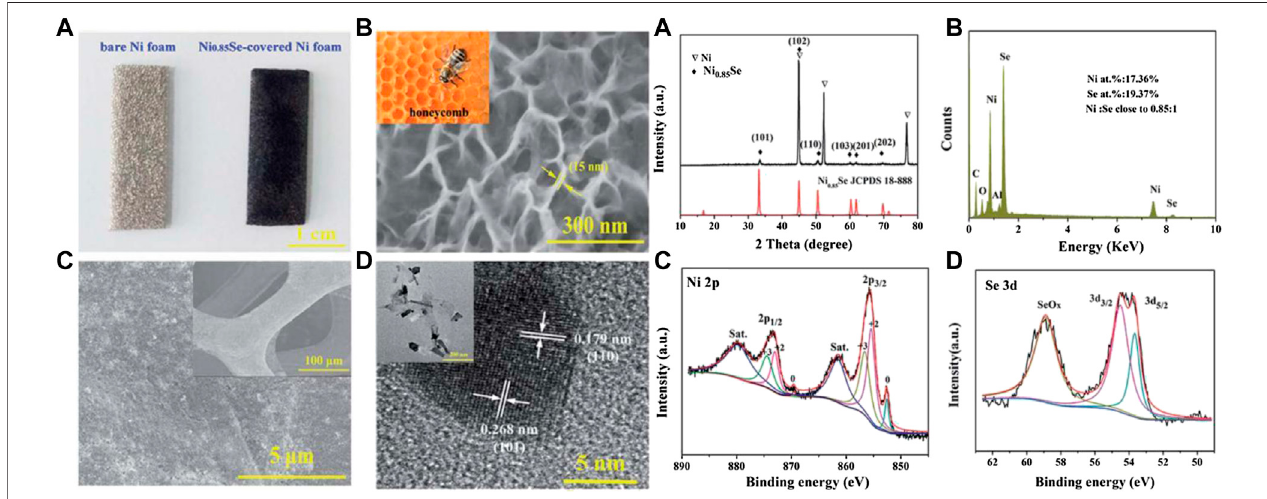
FIGURE 9 | Honeycomb-like metallic nickel selenide nanosheet arrays as binder-free electrodes for high-performance hybrid asymmetric